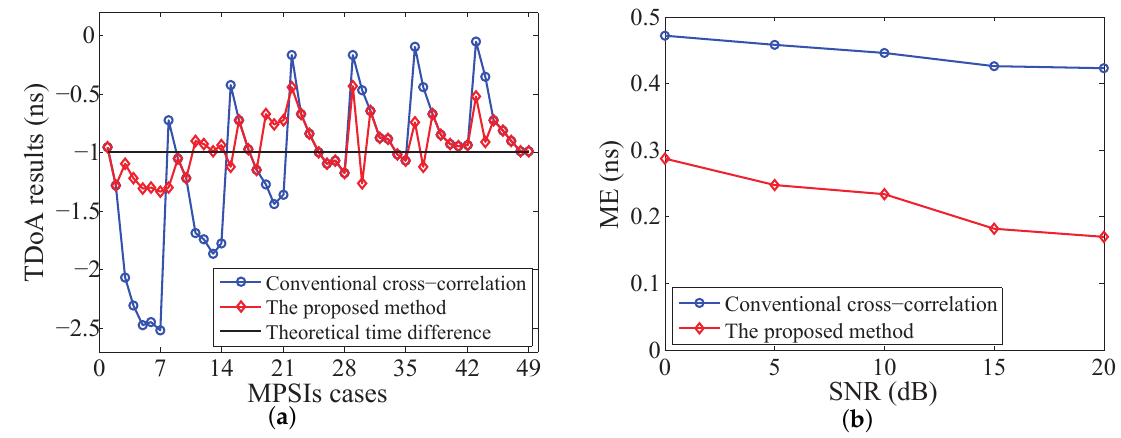
Figure 11. Simulation results of 1D TDoA estimation with different multipath and SNR conditions: ( a ) TDoA calculations of the conventional cross-correlation and the proposed method for 49 MPSIs cases and 15 dB SNR; ( b ) TDoA mean error for different received